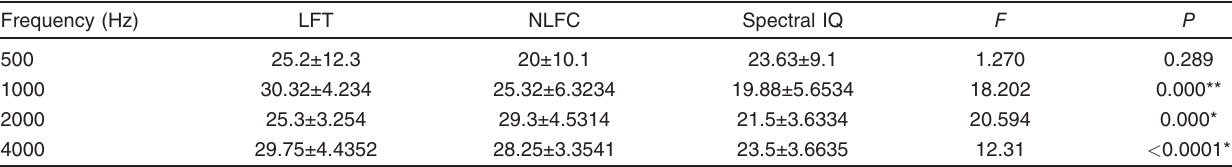
Table 5 Analysis of variance testing for multiple measures was used to compare the three different hearing aids aided thresholds response Frequency